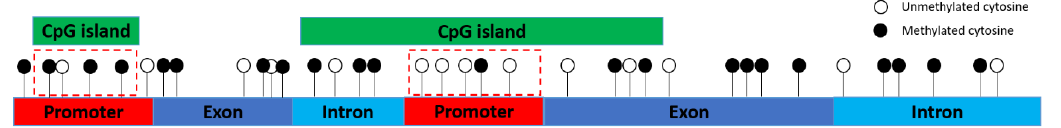
Figure 1. Cytosines (red dotted rectangle) in the promoter-CpG island regions.